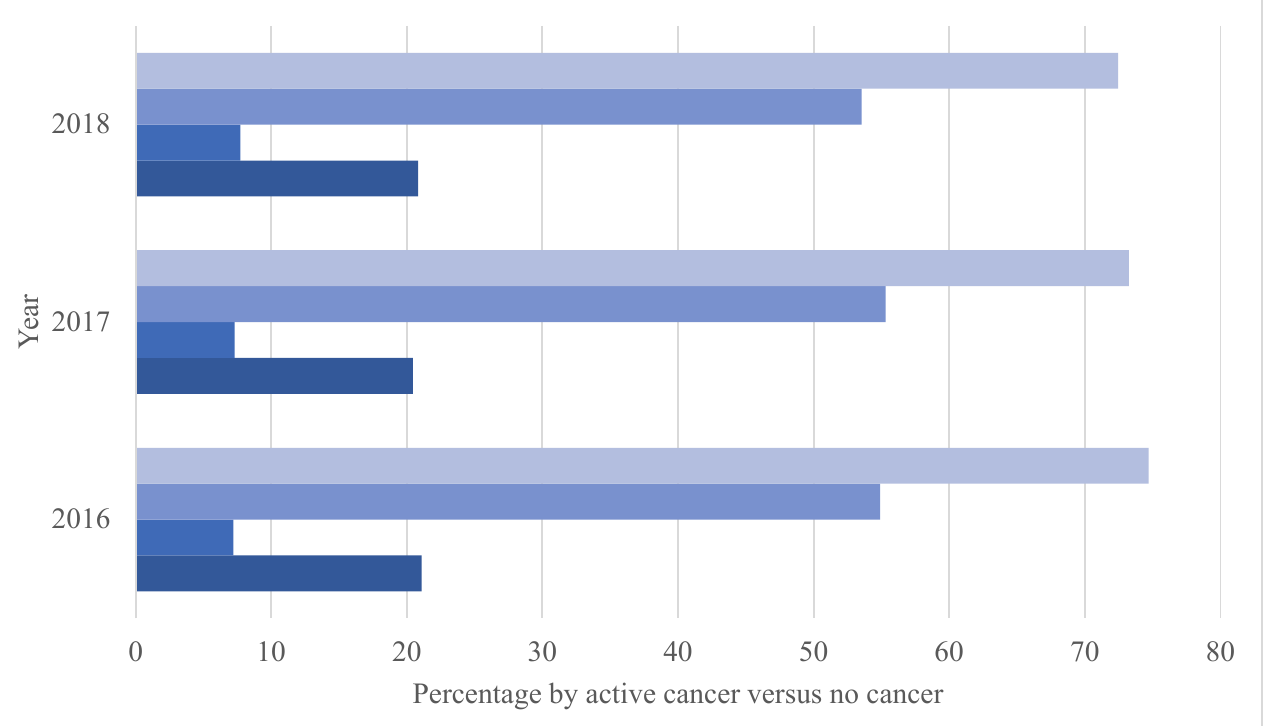
Figure 1. Longitudinal analysis of inpatient mortality and left heart catheterization (LHC) in cardiac arrest by active cancer ( N = 6,656,883).